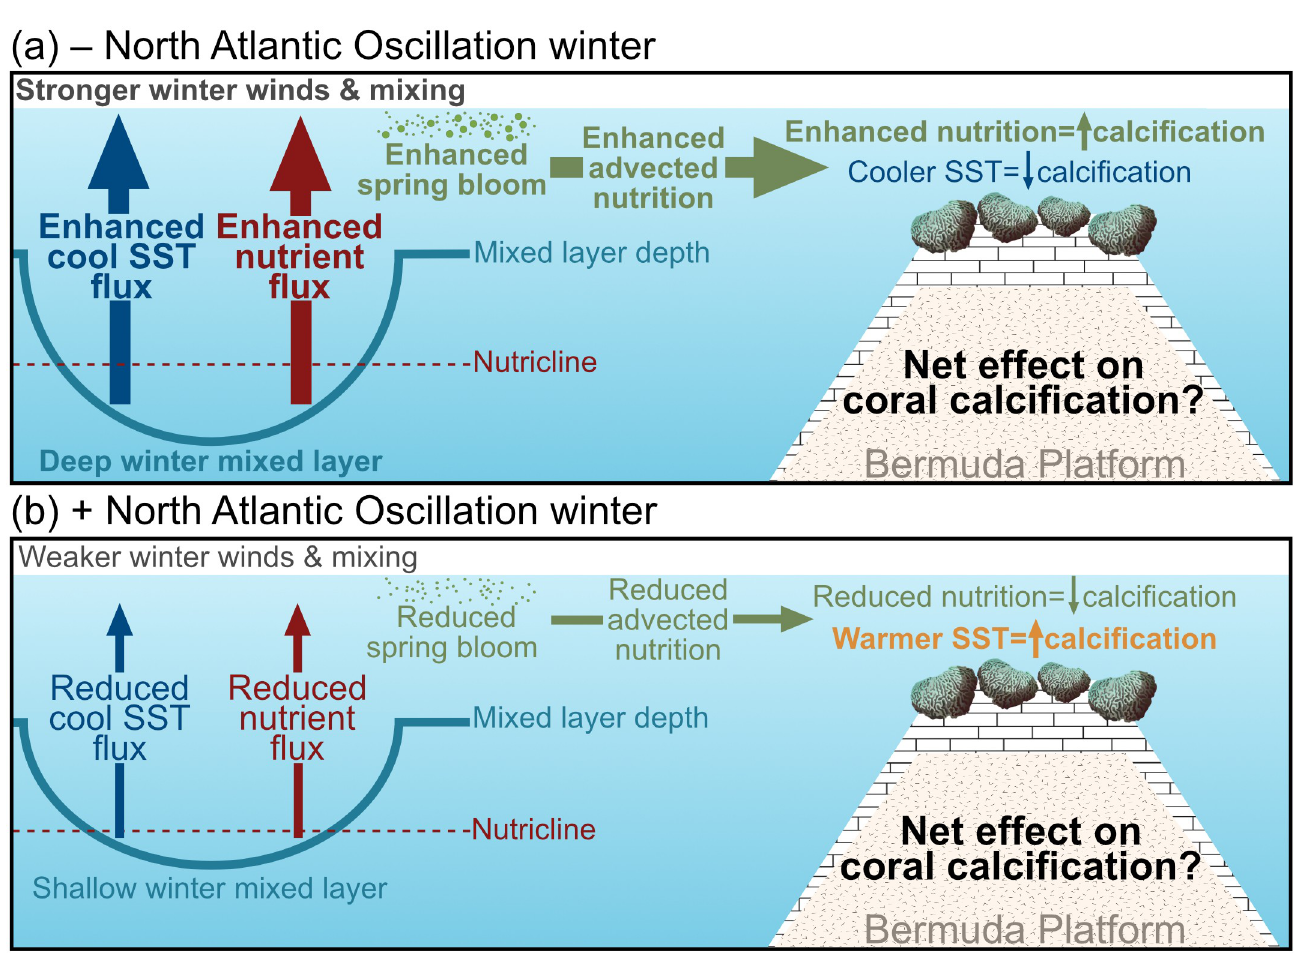
Fig 4. How do changing winter sea surface temperatures (SST) influence high latitude coral calcification rates through the potential interannual tradeoffs between the beneficial effects of warmer SST and enhanced coral nutrition on calcification rates? The figure is modeled after [36] and the brain coral illustration (not drawn to scale) is courtesy of the integration and application network, university of Maryland center for environmental science (ian.umces.edu/ symbols/).